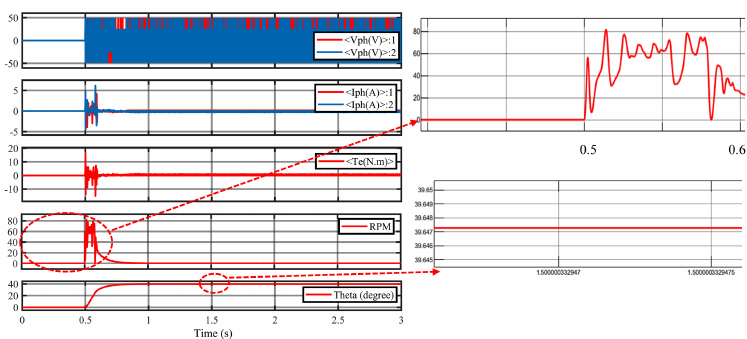
Figure 14. The outputs of stepper motor in the EWB system based on the ADRC controller.